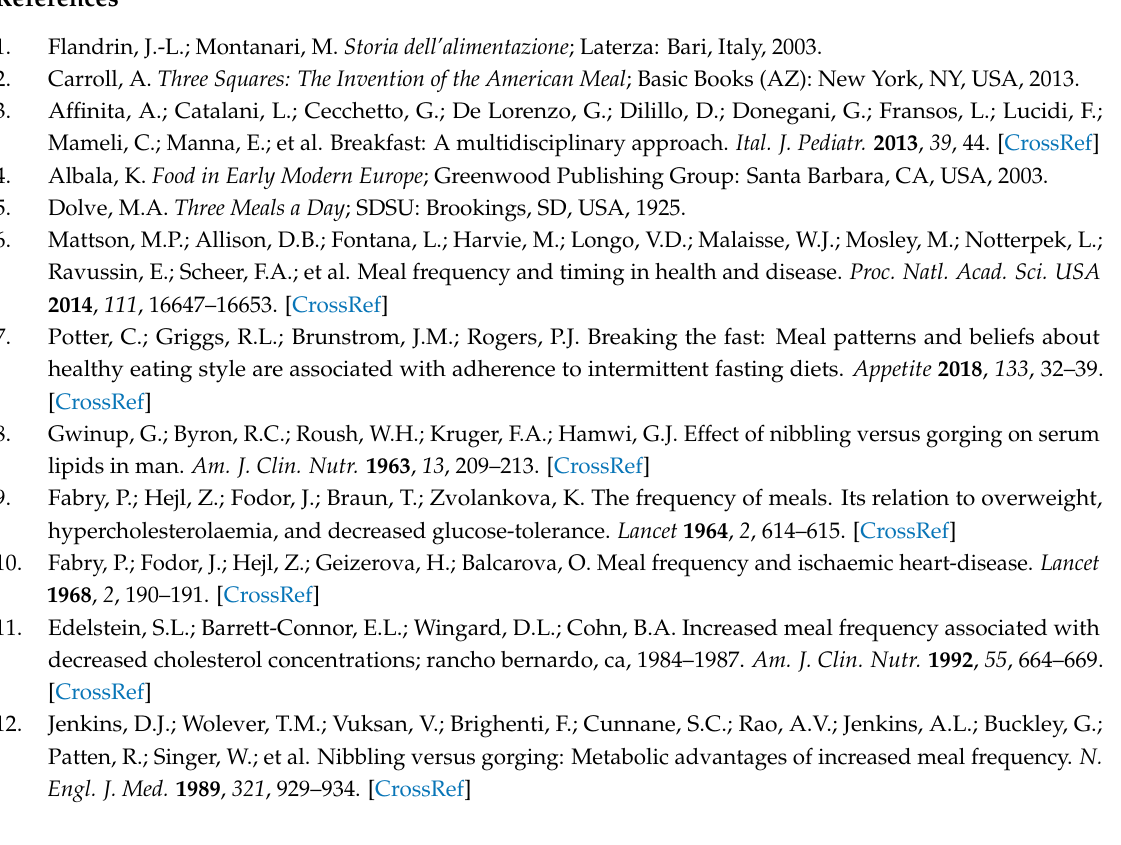
Figure 5. Effects (green: positive; red: negative; blue: neutral) of meal frequency on different CVD risks factors and diseases.CHD: coronary heart disease; CVD: cardiovascular disease.